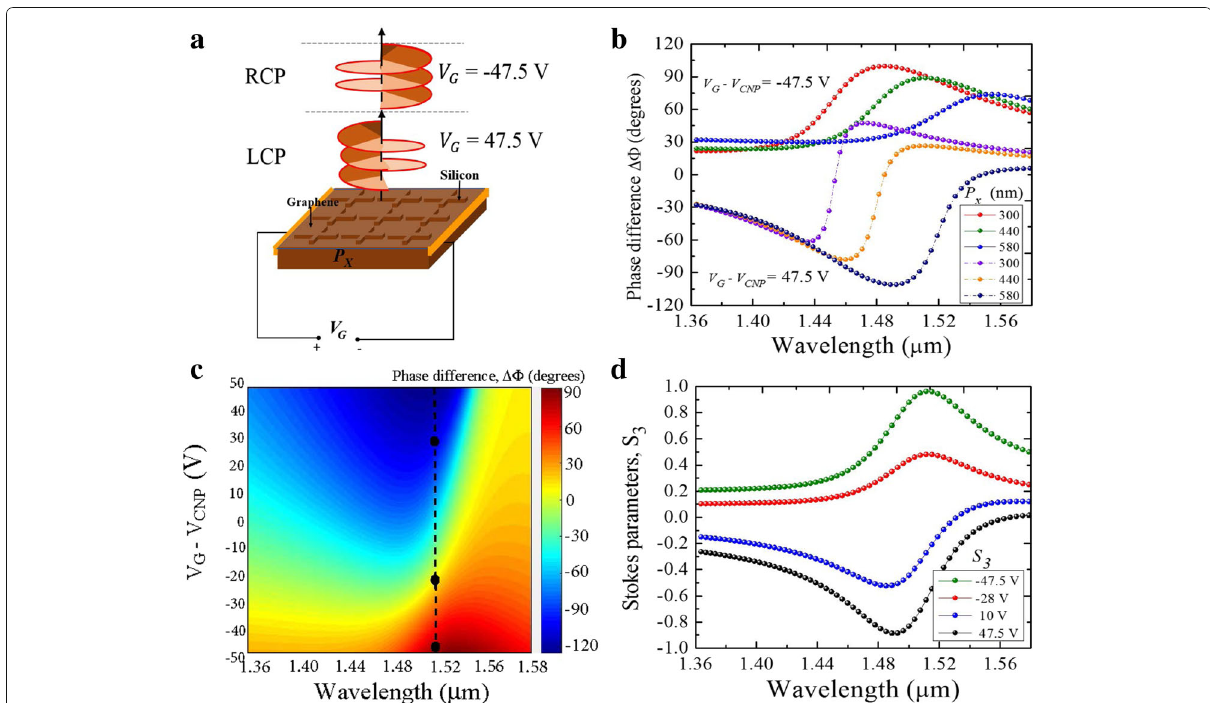
Fig. 7 a Schematic illustration of the silicon/graphene switching of the polarization state through gate voltage biasing. b. Simulated phase difference as a function of gate voltage biasing. c. Phase difference shown as function of periodicity P x and gate voltage. d. Stokes parameter S 3 spectra showing the two states of circular polarization defined by the different gate voltages